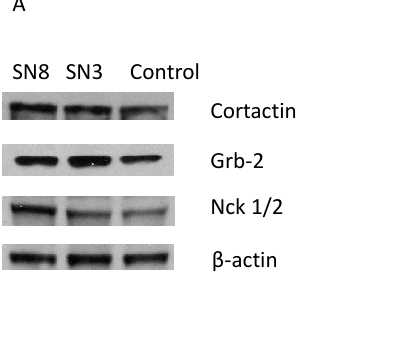
Figure 1. The level of invadosome related proteins in HT-29 with Snail overexpression. Protein extracts from HT-29 stably transfected with pcDNA (control) or pcDNA/Snail vector (clone 8-SN8, clone 3-SN3) were harvested and analyzed by western blot using specific antibodies as described in methods section. ( A ) Grb2, Nck1/2, and cortactin level detected by western blot and ( B ) analyzed by densitometry and ImageJ software, performed out of 5 independent western blot experiments. The level of Snail expression in HT 29 clones, SN3 and SN8 have been shown previously [9]. ** p >